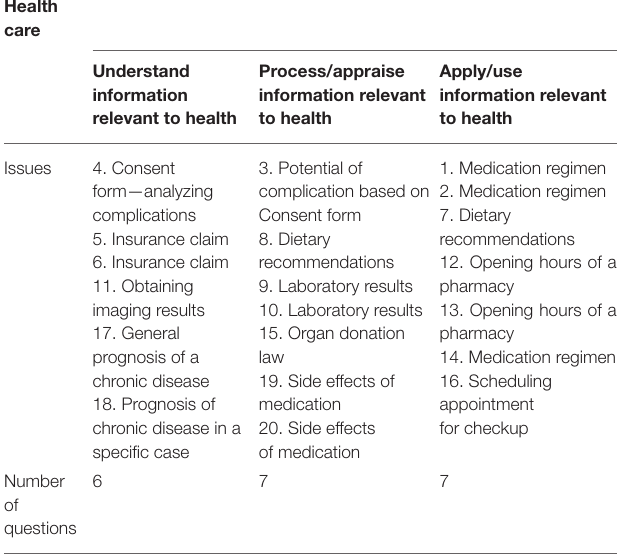
TABLE 1 | Topics of the patient education materials selected for assessing